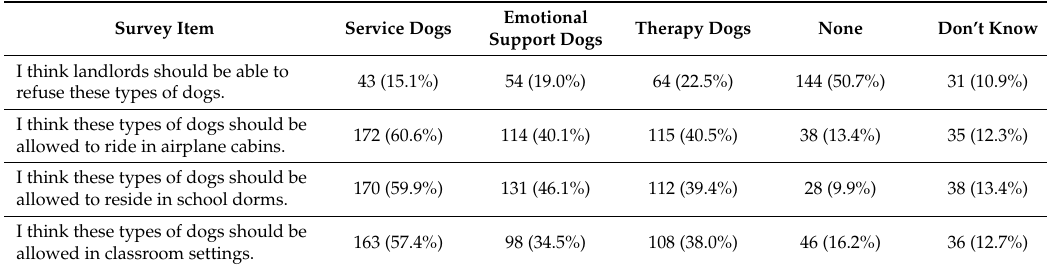
Table 5. Public perceptions of appropriate levels of access for assistance dogs. Participants were able to select as many types of assistance dogs as they felt applicable for each